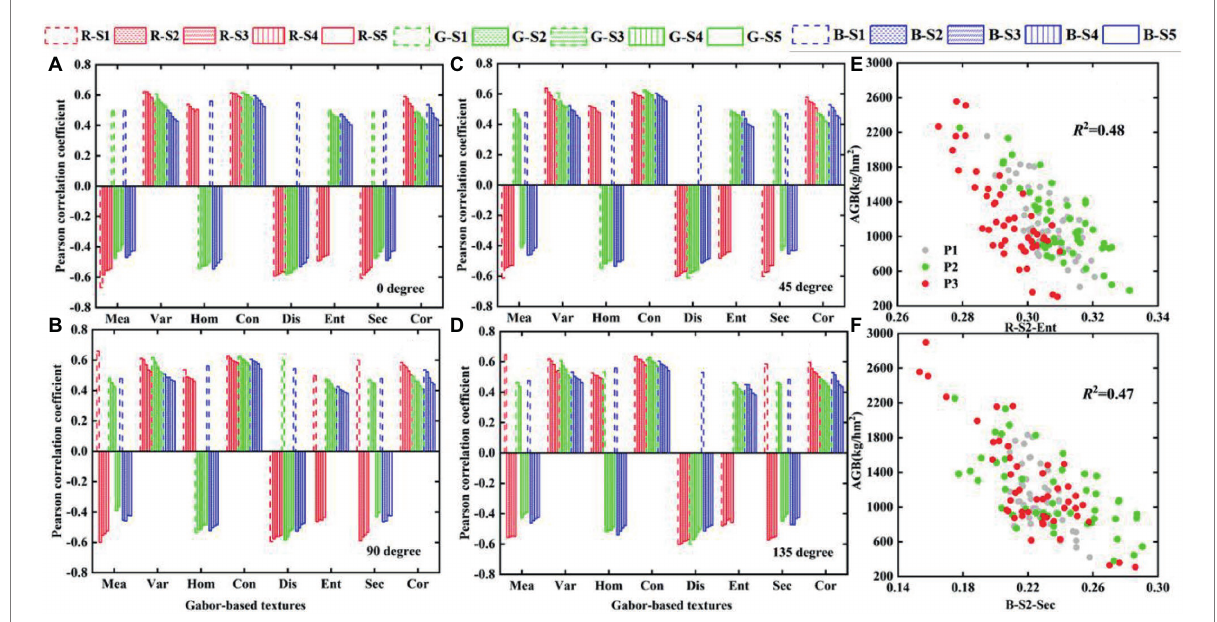
FIGURE 8 The relationship between Gabor-based textures and AGB in different directions and different scales: (A) 0-degree, (B) 45-degree, (C) 90-degree, (D) 135-degree, (E,F) scatter plots of R-S2-Ent and B-S2-Sec with AGB, respectively.